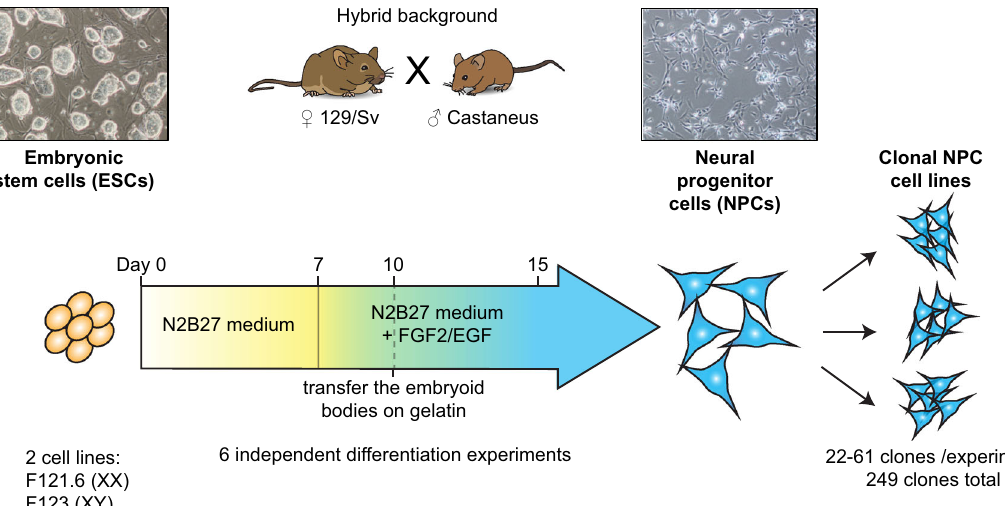
Fig. 1 Experimental strategy to assess the frequency of monoallelic expression. Generation of NPC clonal cell lines (249 clones in total) from two hybrid ESC lines after six independent in vitro differentiation